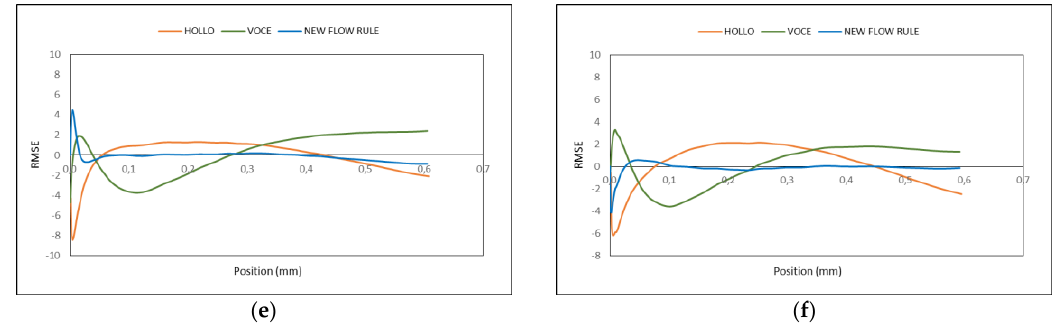
Figure 10. RMSE graphs of each flow rule in relation to the experimental curve for AA5754: ( a ) AA5754 at N0 and 25 °C; ( b ) AA5754 at N0 and 250 °C; ( c ) AA5754 at N2 and 25 °C; ( d ) AA5754 at N2 and 250 °C; ( e ) AA5754 at N2 + flash and 25 °C; ( f ) AA5754 at N2 + flash and 250 °C.